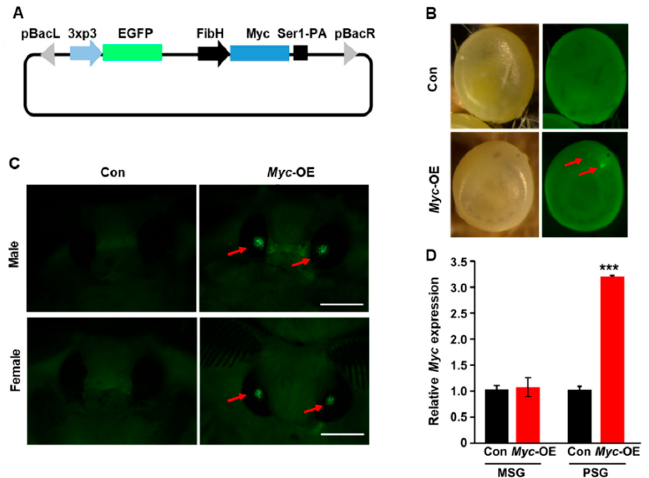
Figure 1. Generation of transgenic silkworm with PSG-specific Myc overexpression. ( A ) Schematic illustration of the vector for Myc overexpression driven by the FibH promoter. ( B , C ) EGFP-positive eggs ( B ) and adults ( C ) were screened in G1 generation. ( D ) Myc was highly expressed in the PSG of transgenic silkworm. Values are represented as means ± S.E. (error bars). For the significance test: *** p < 0.001 vs. the control.